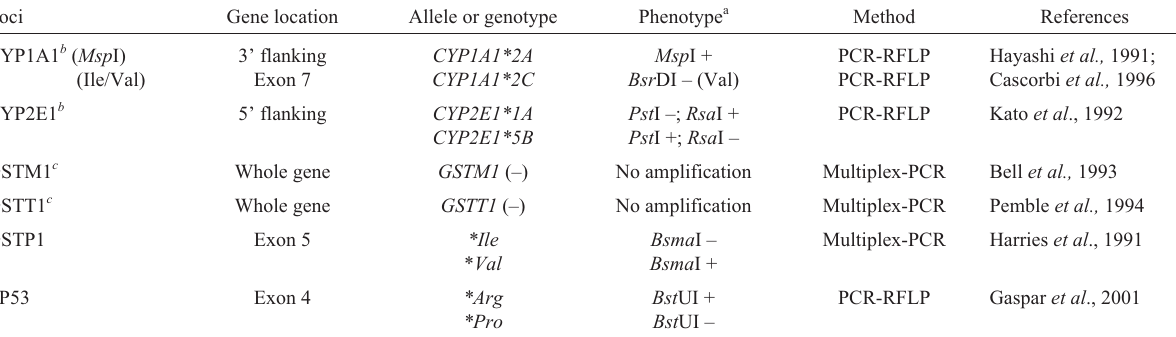
Table 1 - Characteristics of the cytochrome P ( CYP1A1 , CYP2E1 ), glutathione-S-transferase ( GSTM1 , GSTT1 , GSTP1 ) and tumor suppressor ( TP53 ) polymorphisms investigated in this study. Loci Gene location Allele or